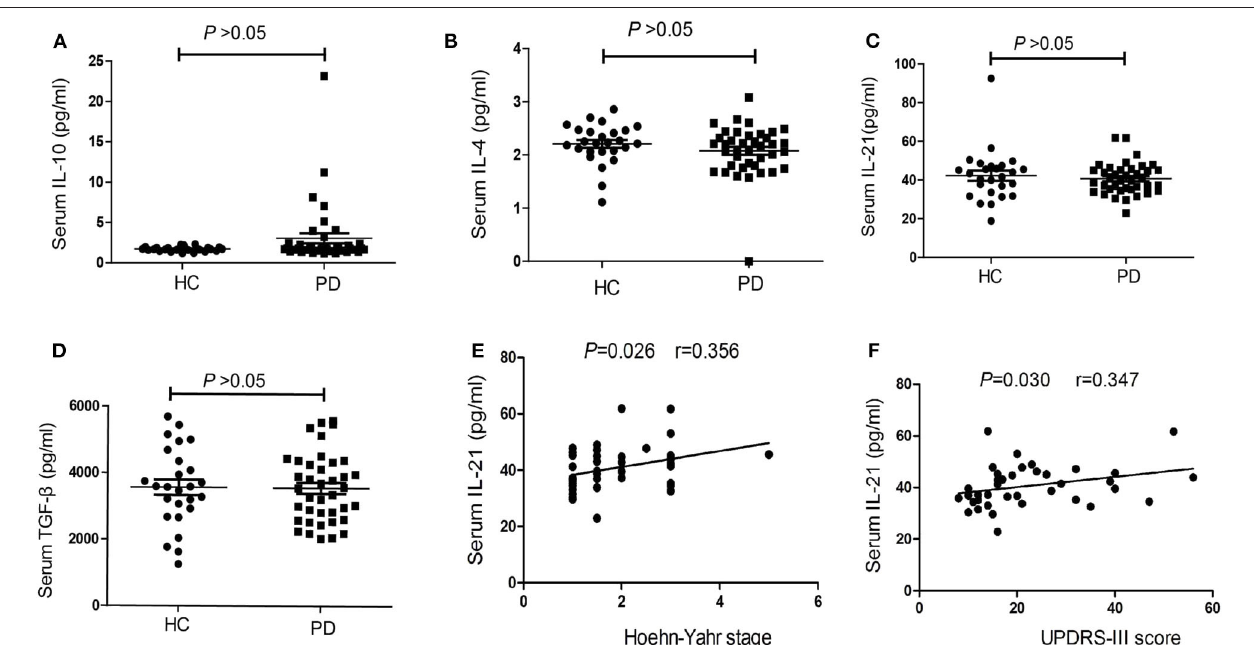
FIGURE 4 | The concentrations and correlation analysis of IL-4, IL-10, IL-21, and TGF- β in PD patients. (A) The comparison of the IL-10 between PD patients and HCs ( P > 0.05). (B) A comparison of the IL-4 in PD patients and HCs ( P > 0.05). (C) The comparison of the IL-21between PD patients and HCs ( P > 0.05). (D) A comparison of the TGF- β in PD patients and HCs ( P > 0.05). (E) The correlation analysis of the serum IL-21 concentrations in PD patients with H-Y stage ( P < 0.05). (F) The correlation analysis of the serum IL-21 concentrations in PD patients with UPDRS-III score ( P <